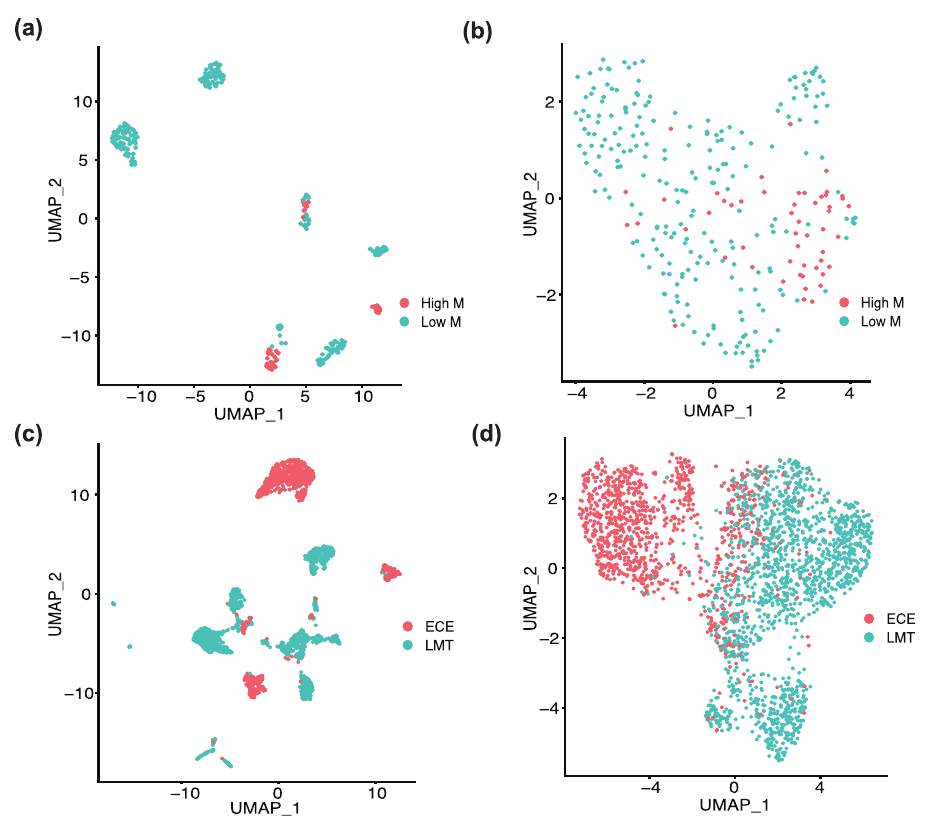
Fig 4. Functional validation of the metastasis-predictive genes inferred by PLUS from TCGA data. (a-b) Cell clusters of the cancer cells with high (High_M, red) and low (Low_M, blue) metastatic potential obtained by using all genes (a, silhouette coefficient = 0.07) and the PLUS selected metastasis predictive genes (b, silhouette coefficient = 0.36) in the scRNA-seq dataset for breast cancer (GSE75688). (c-d) Cell clusters of cancer cells from cancer tissues with (ECE, red) and without (LMT, blue) extracapsular extension obtained by using all genes (c, silhouette coefficient = 0.1) and the PLUS-selected metastasis-predictive genes (d, silhouette coefficient = 0.3) in the scRNA-seq dataset for head and neck cancer